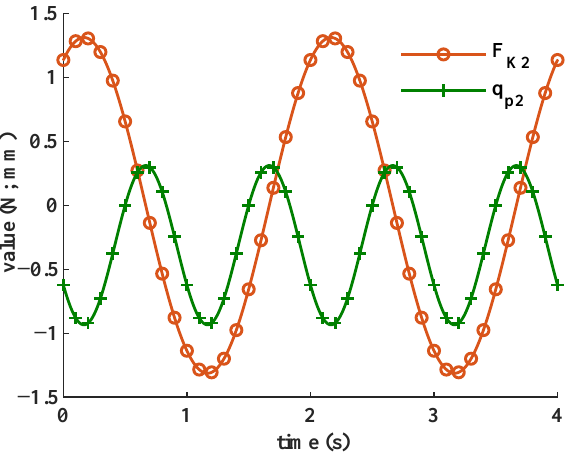
Figure 13. Stiffness-related component, F K 2 , of the required active force, and the corresponding flexure-based passive prismatic joint displacement q p 2